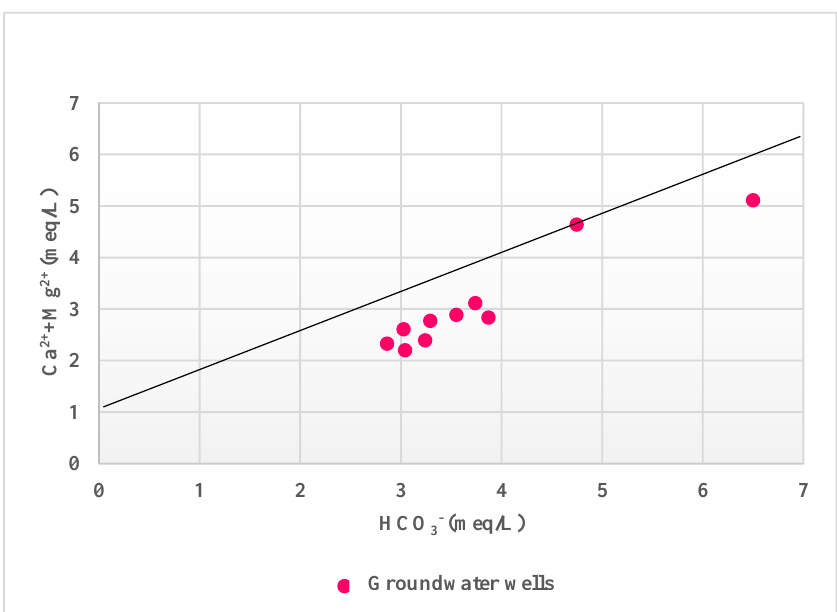
Figure 10. Binary hydrogeochemical diagram of the dissolution of calcite or dolomite in the study area.